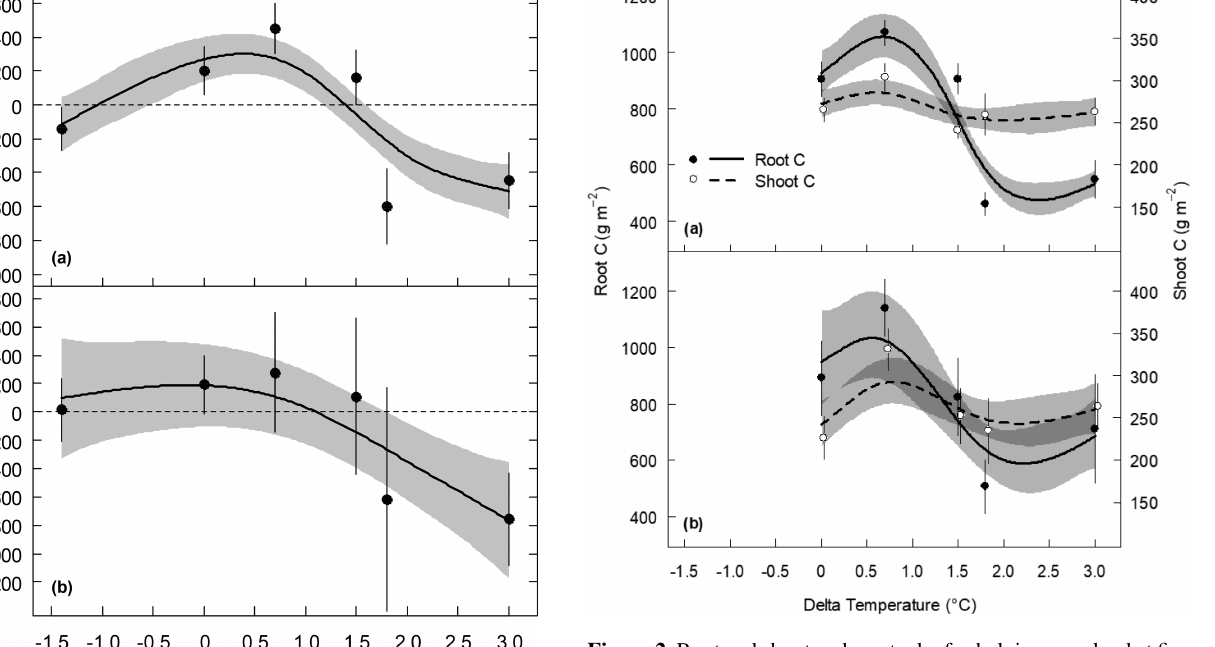
Figure 2. Root and shoot carbon stock of subalpine grassland at five climate scenario sites (CSs) as a function of the temperature change (Delta temperature of the April–October mean) induced by the cli- mate scenario treatment. Data are from 2017, after 5 years of exper- imental duration. (a) All monoliths, pooled across the irrigation and N treatments and (b) control monoliths only that received neither ir- rigation nor additional N. Symbols are means ± 1SE, and predicted lines are based on a generalized additive model to all monoliths per group ( ± 1SE, grey shaded; dark grey indicates the cross section of the two SE bands). See Appendix Tables B5 and B6 for the GAM summaries. No data were available for the CS1 site. Overlapping means and SEs are shifted horizontally to improve their visibility, and note the different y axes for root and shoot